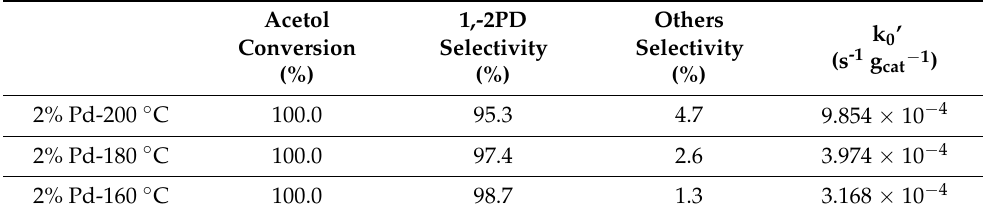
Table A6. Acetol hydrogenation at different temperatures a .